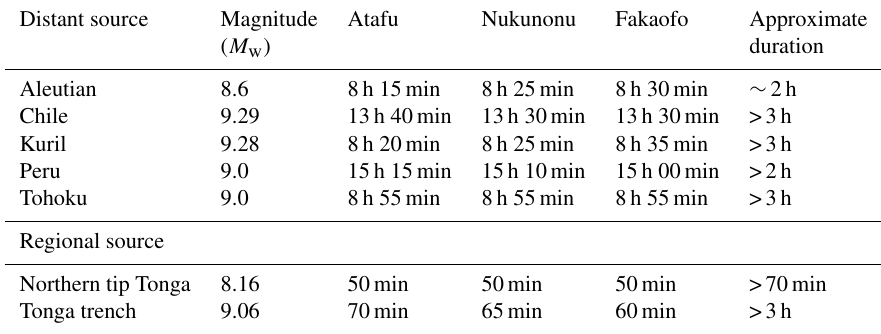
Table 3. Arrival times in hours (h) and minutes (min) for waves from distant- and regional-earthquake simulations. The first occurrences of tsunami waves greater than 10cm height are used to define initial arrival times at Tokelau and approximate tsunami event duration. Distant source Magnitude Atafu